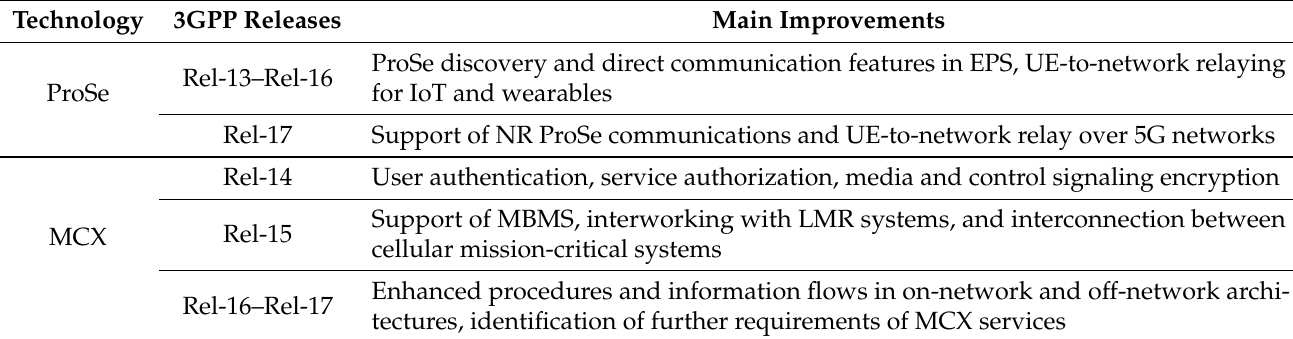
Figure 1. On-network and off-network functional modes for MCX services. Table 2. Enhancements of public-safety-targeted cellular